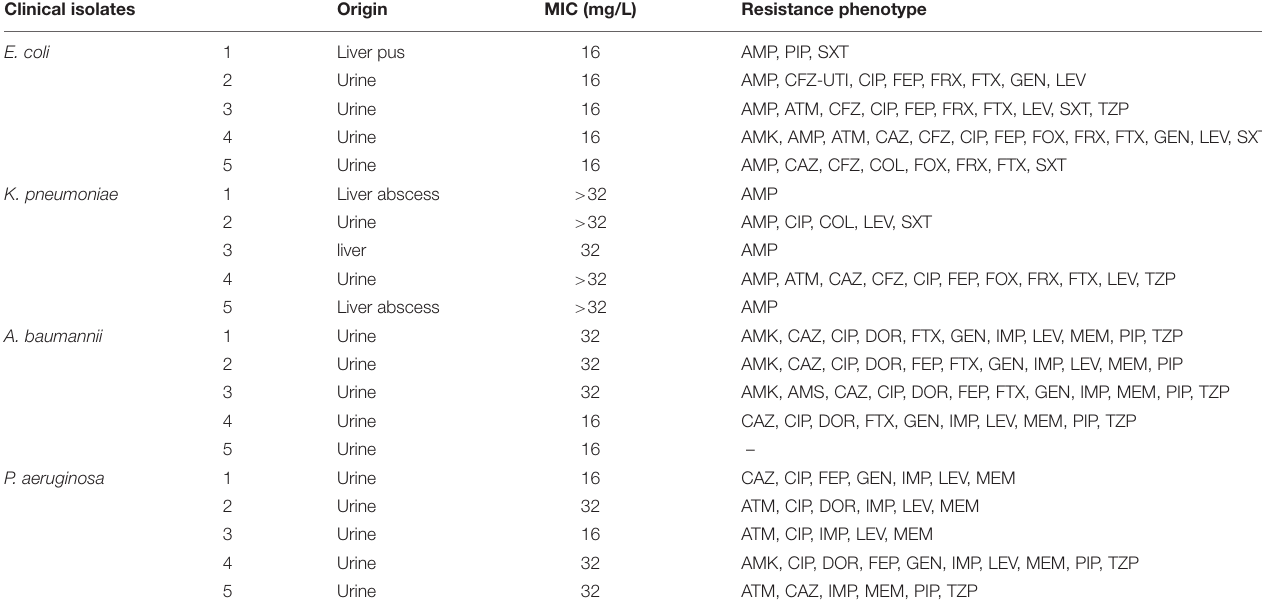
TABLE 2 | Minimum inhibitory concentration (MIC) of D-150-177C against antibiotics-resistant bacterial isolates. Clinical isolates Origin MIC (mg/L)